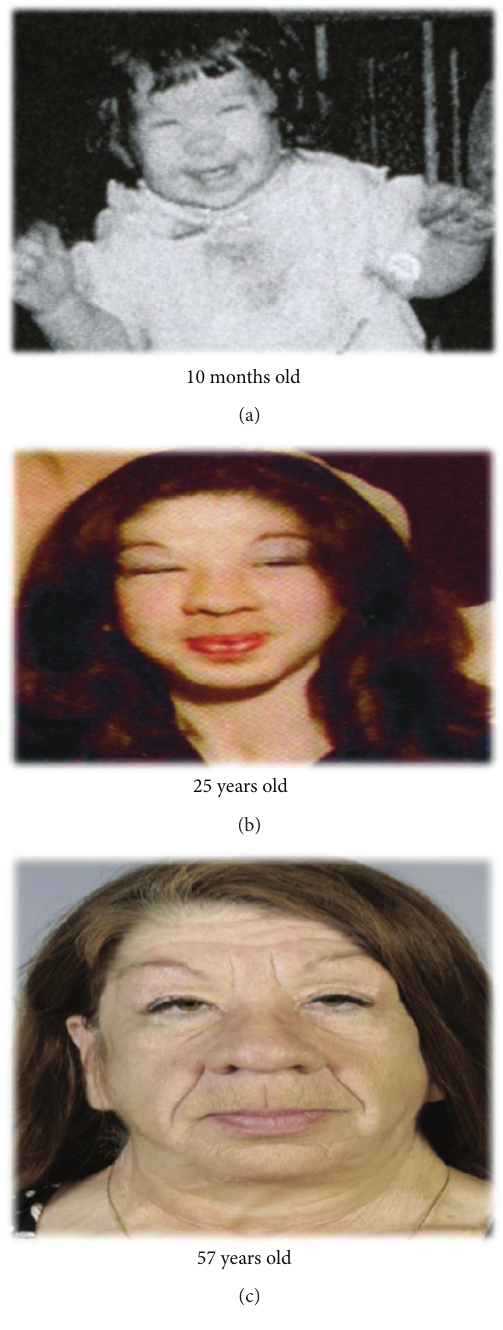
Figure 1: Coarse facies and bulbous nose, present since